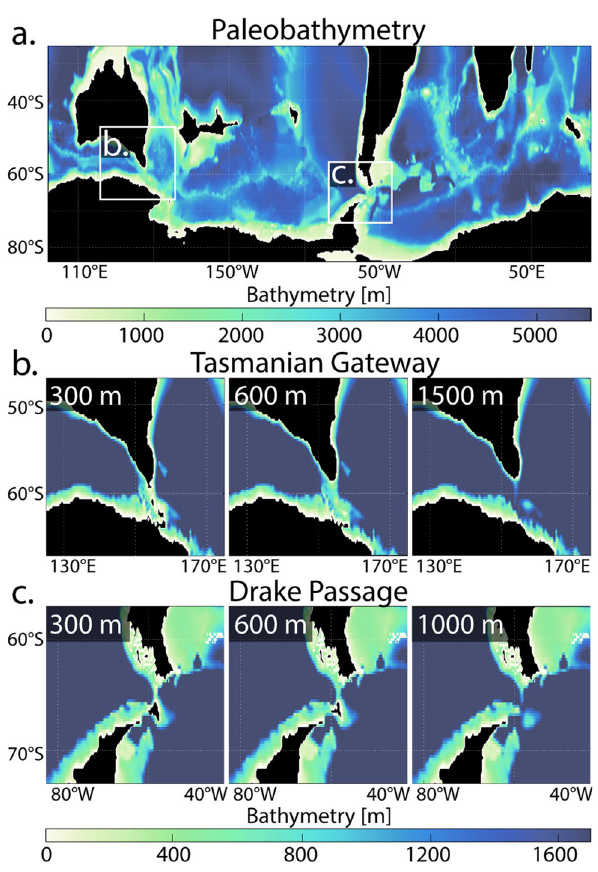
Fig. 1 Paleobathymetry and gateway depths con fi gurations. a High- resolution (0.25°) bathymetry of the Southern Ocean reconstructed to the Late Eocene (38 million years ago). b , c Stepwise subsidence of the ( b ) Tasmanian Gateway (TG) and ( c ) Drake Passage (DP), with depths adjusted to 300, 600 and 1000m (DP) / 1500 m (TG). Black regions are above sea